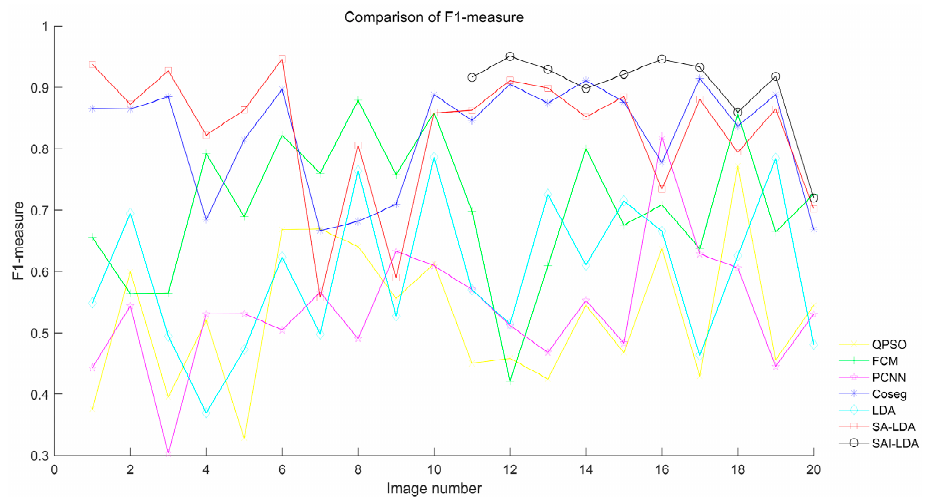
Figure 23. Comparison of F 1 -measure value.